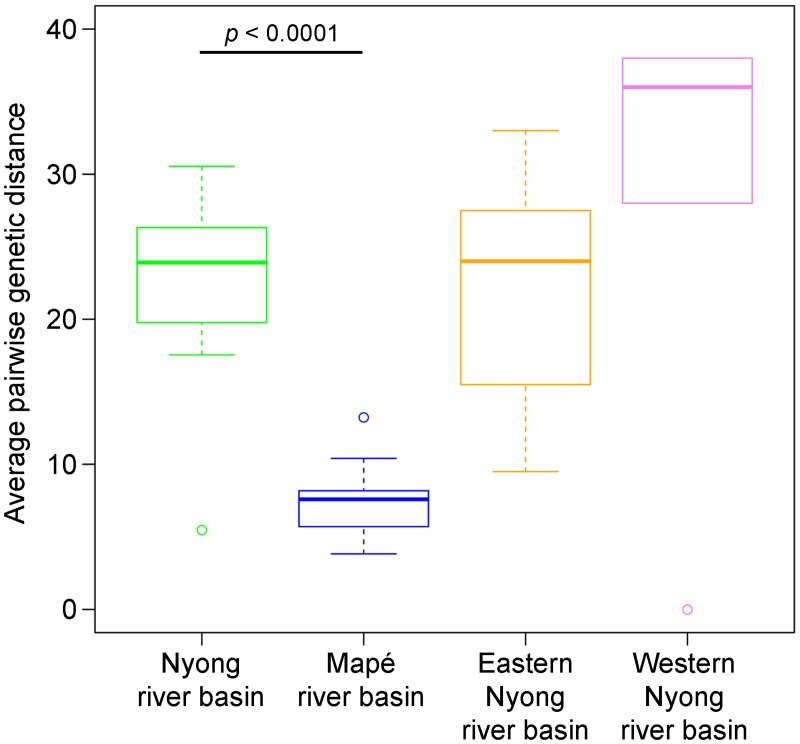
SNP pairwise distance between isolates from the same lineage.The variation in the average SNP pairwise distance per genome for each lineage (Mapé and Nyong river basin strains) is shown in a box plot, with circles representing outlier sequence pairs. Two sub-areas of the Nyong river basin: the Eastern Nyong river basin and Western Nyong river basin, which are each smaller than the Mapé river basin area, are additionally shown. Statistical significance was assessed with the Wilcoxon rank sum test.